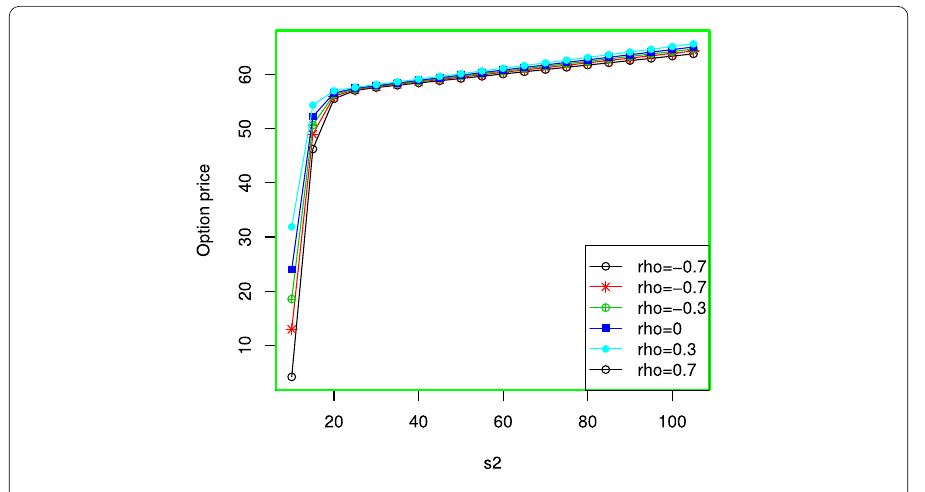
Figure 4 Vulnerable call option for different values of ρ 1 and s 2